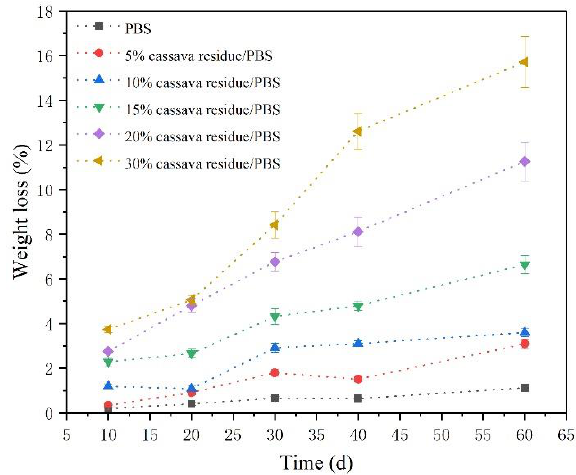
Figure 8. Weight loss of pure PBS and cassava residue/PBS composite.